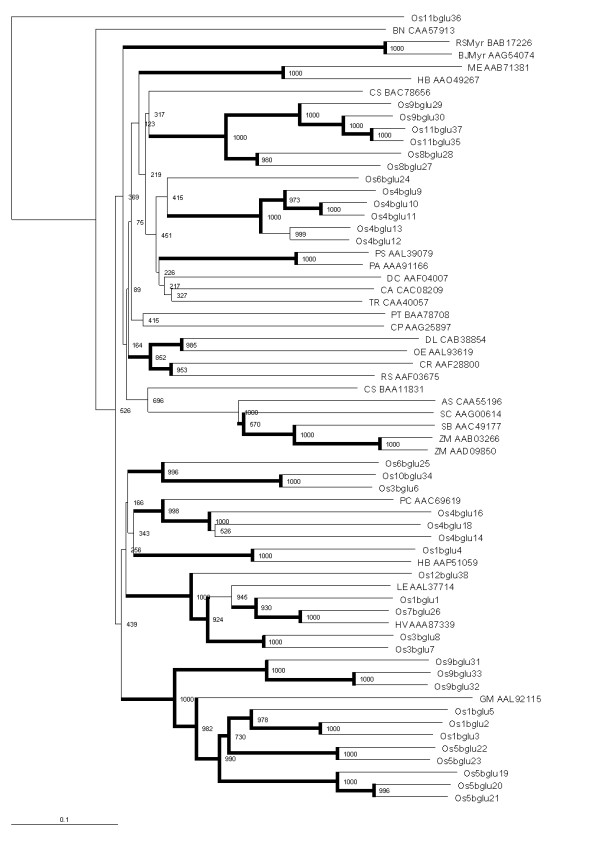
Relationship between rice and other plant GH1 protein sequences described by a phylogenetic tree rooted by Os11bglu36. The sequences were aligned with ClustalX, then manually adjusted, followed by removal of N-terminal, C-terminal and large gap regions to build the data model. The tree was produced by the neighbor joining method and analyzed with 1000 bootstrap replicates. The internal branches supported by a maximum parsimony tree made from the same sequences are shown as bold lines. The sequences other than rice include: ME AAB71381, Manihot esculenta linamarase; RSMyr BAB17226, Raphanus sativus myrosinase; BJMyr AAG54074, Brassica juncea myrosinase; BN CAA57913, Brassica napus zeatin-O-glucoside-degrading β-glucosidase; HB AAO49267, Hevea brasiliensis rubber tree β-glucosidase; CS BAA11831, Costus speciosus furostanol glycoside 26-O-β-glucosidase (F26G); PS AAL39079Prunus serotina prunasin hydrolase isoform PH B precursor; PA AAA91166, Prunus avium ripening fruit β-glucosidase; TR CAA40057, Trifolium repens white clover linamarase; CA CAC08209, Cicer arietinum epicotyl β-glucosidase with expression modified by osmotic stress; DC AAF04007, Dalbergia cochinchinensis dalcochinin 8'-O-β-glucoside β-glucosidase; PT BAA78708, Polygonum tinctorium β-glucosidase; DL CAB38854, Digitalis lanata cardenolide 16-O-glucohydrolase; OE AAL93619, Olea europaea subsp. europaea β-glucosidase; CR AAF28800, Catharanthus roseus strictosidine β-glucosidase; RS AAF03675, Rauvolfia serpentina raucaffricine-O-β-D-glucosidase; CP AAG25897, Cucurbita pepo silverleaf whitefly-induced protein 3; AS CAA55196, Avena sativa β-glucosidase; SC AAG00614, Secale cereale β-glucosidase; ZM AAB03266, Zea mays cytokinin β-glucosidase; ZM AAD09850, Zea mays β-glucosidase; SB AAC49177, Sorghum bicolor dhurrinase; LE AAL37714, Lycopersicon esculentum β-mannosidase; HV AAA87339, barley BGQ60 β-glucosidase; HB AAP51059, Hevea brasiliensis latex cyanogenic β-glucosidase; PC AAC69619Pinus contorta coniferin β-glucosidase; GM AAL92115, Glycine max hydroxyisourate hydrolase; CS BAC78656, Camellia sinensis β-primeverosidase.